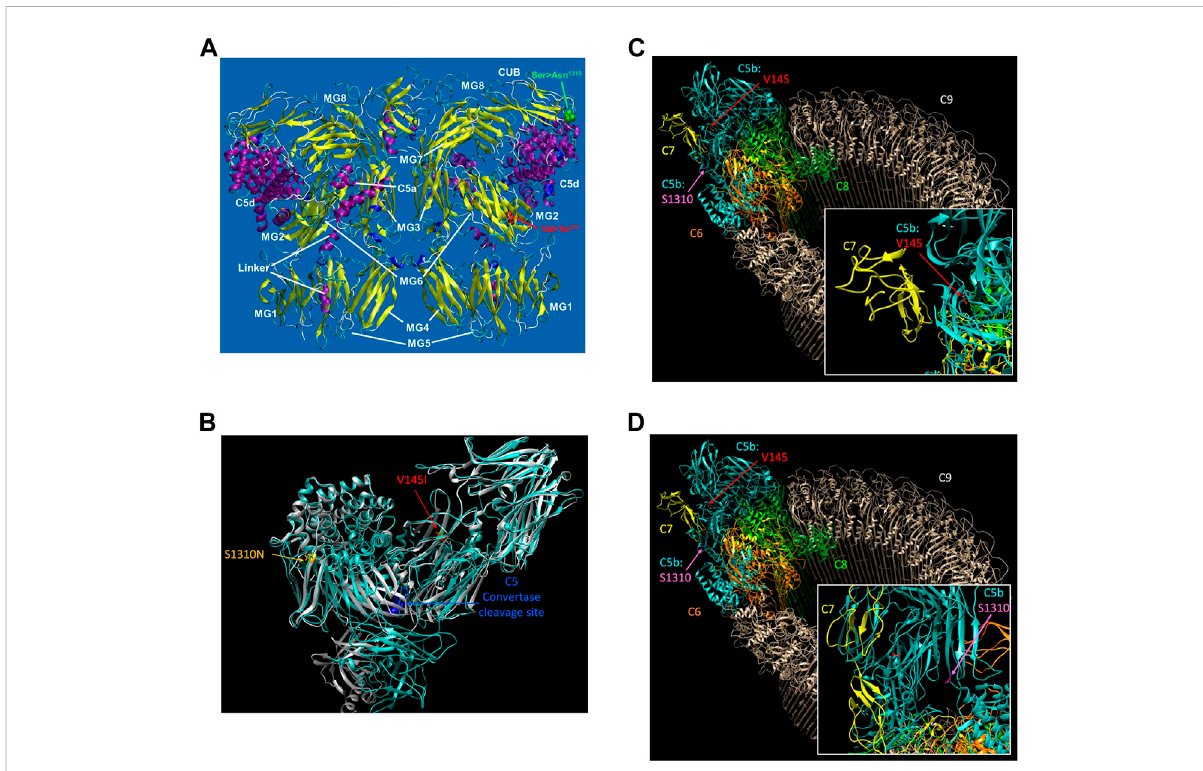
FIGURE 1 The reference sequence for the human C5 protein was retrieved from Genbank at the NCBI with the accession number NP_001304092. The potential impact of the C5 SNPs on the overall protein structure were investigated using AlphaFold (Varadi et al., 2022) with 3D protein structures visualized usingUCSFChimera(Pettersenetal.,2004) (A) .ThestructureofC5showingthevarious domainsi.e., macroglobulin(MG)1-MG8.Relative to the published C5 structure (Fredslund et al., 2008), we observed that Val145le mutation is located in the macroglobulin MG2 domain, while the Ser1310Asn is located on the CUB (B) . AlphaFold structure prediction of rs17216529:C > T and rs17610:C > T. Inspection of the wild-type (WT) and mutant proteins revealed no signi fi cant perturbations to the overall structure. However, subtle changes that may not be detected by AlphaFold may impact on the unstable C5b. The WT molecule for both V145I and S1310N are colored green, while the mutant for V145I is colored red and that of S1310N is colored orange (C) . AlphaFold structure prediction of the two SNPs relative to the cleavage site for C5 convertase. Examination of the structure revealed that the SNPs are also distal from the C5 convertase cleavage site. Additionally, the WT structure of both C5 and C5b in the MAC, rs17216529:C > T appeared to be buried, orienting the hydrophobic side chain into the protein. On the other hand, we did not observe a clear interaction partner for rs17216529:C > T neither in the C5 nor MAC structures. However, the mutation is located near the C5b and C7 in the MAC structure (D) . AlphaFold structure prediction of the location of mutation on rs17610:C > T. Examination of the C5 protein structure revealed that the mutation is exposed both on the C5 protein, and in the